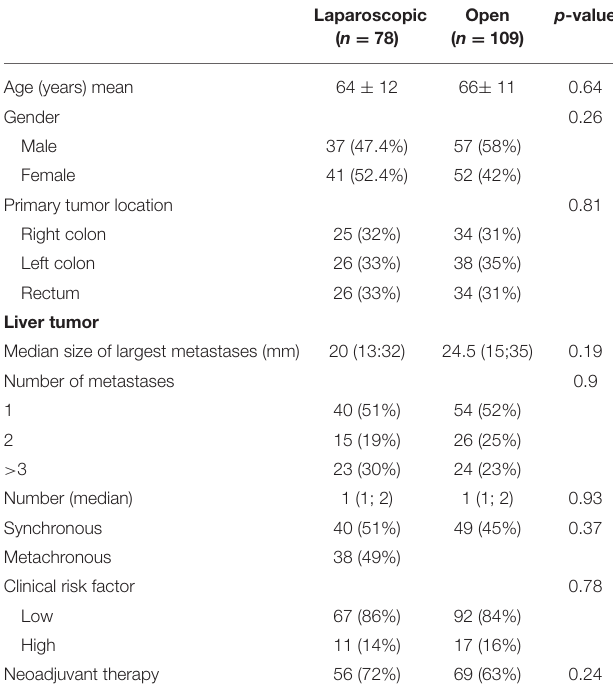
TABLE 1 | Baseline demographical, liver and colorectal